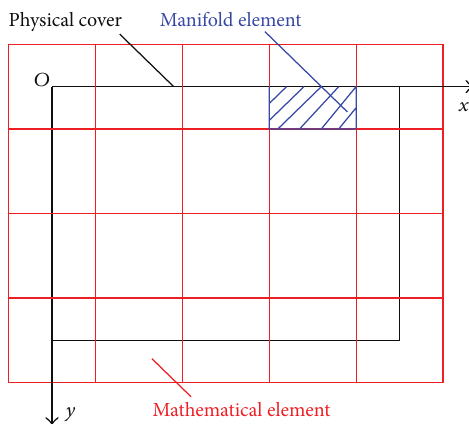
coefficient of the penalty function is 𝛽 𝑖 = 1.0 × 10 9 , the material density is 𝜌 = 4×10 4 kg/m 3 , the damping coefficient is 𝑐 = 0 , and the coefficient of the Wilson- 𝜃 method is 𝜃 = 1.4 . Different time steps Δ𝑡 are selected for the calculation. As shown in Figure 5, the fixed rectangular mesh is used as the mathematical cover. The shaded area in the figure denotes any calculated manifold element.